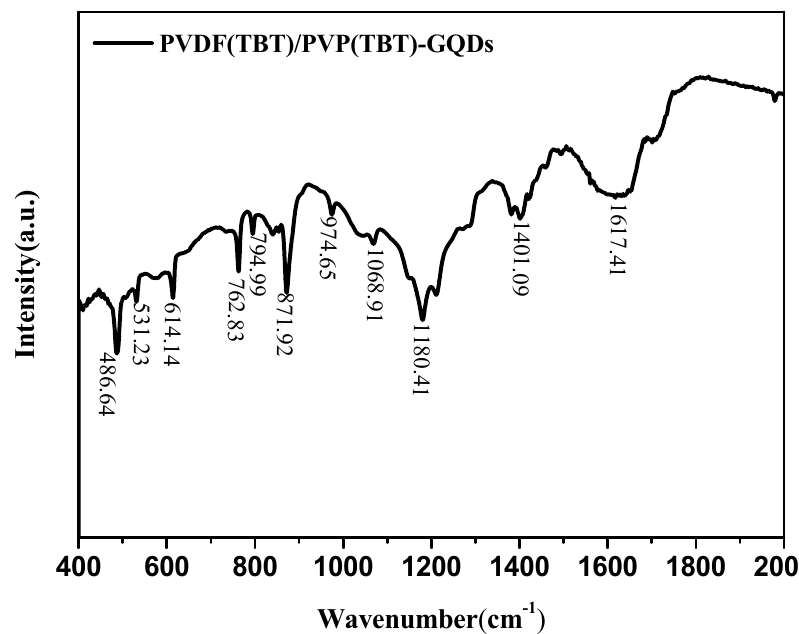
Figure 6. The infrared spectra of PVDF(TBT)/PVP(TBT)-GQDs.